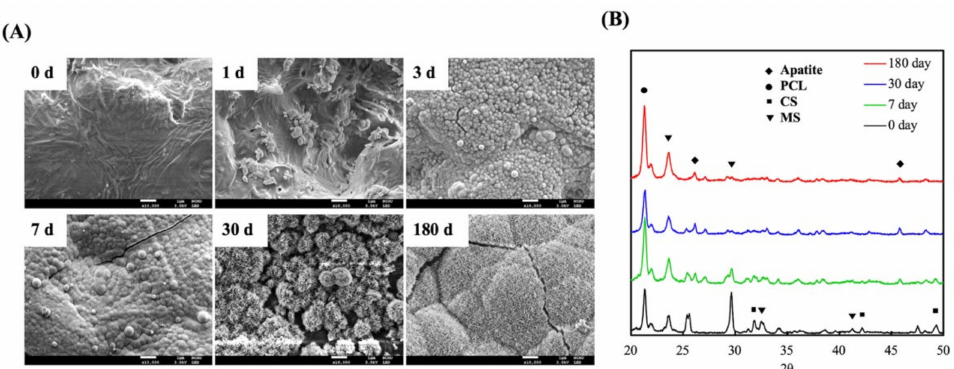
Figure 2. ( A ) Field emission–scanning electron microscopy (FE-SEM) photographs and ( B ) X-ray diffractometry (XRD) of an MS/CS scaffold after soaking in SBF. The scale bar of the SEM photograph is 1 µ